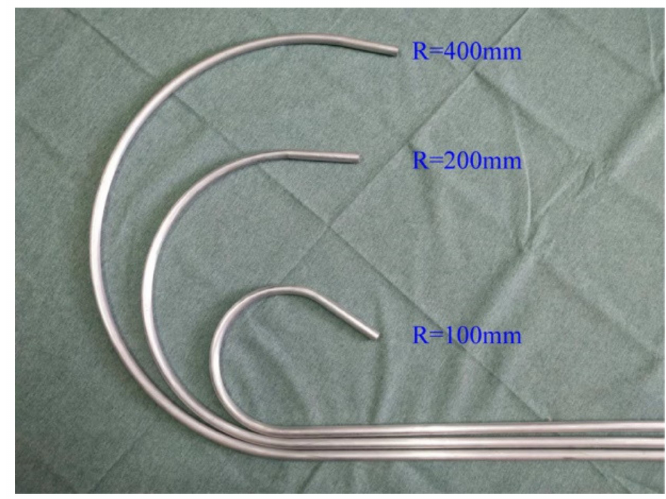
Figure 14. Tube processing in a four-axis free-form bending device.